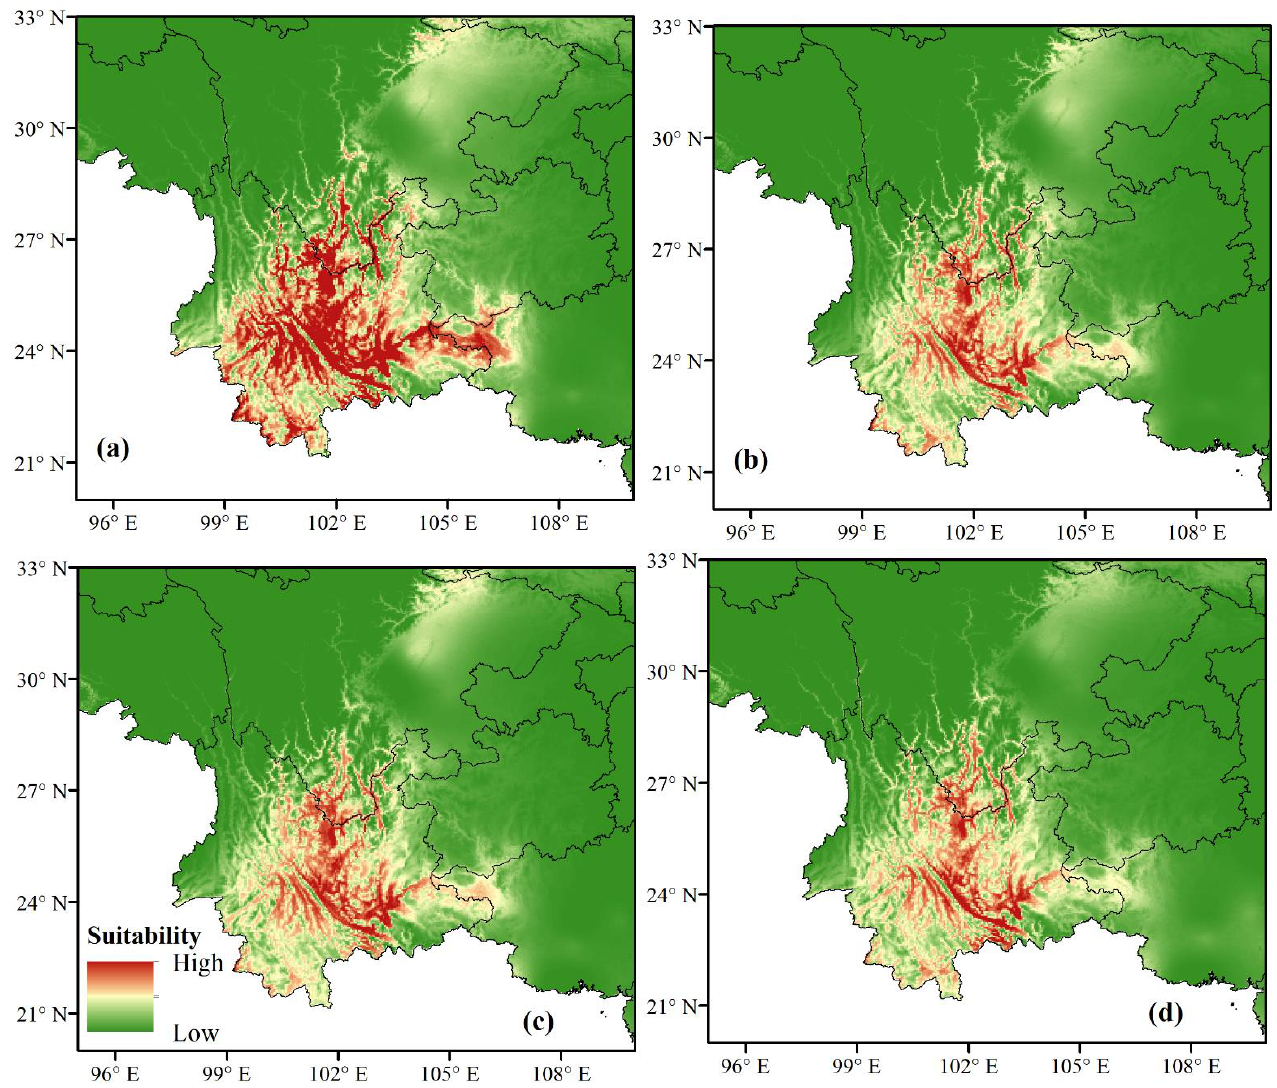
Figure 4. Predicted habitat suitability of Garuga forrestii under future climatic conditions — (a ) RCP4.5 scenario (2050), ( b ) RCP8.5 scenario (2050), ( c ) RCP4.5 scenario (2070) and ( d ) RCP8.5 scenario (2070).